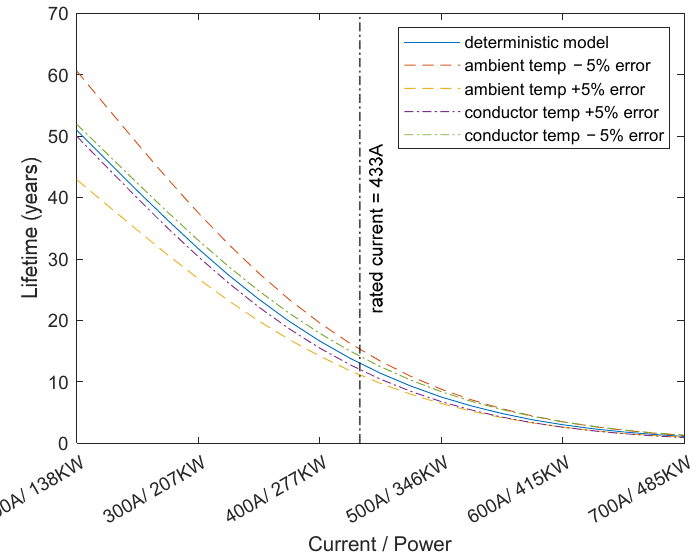
Figure 6. The lifetime curve for applied current and loading for the 300 mm 2 waveform cable.